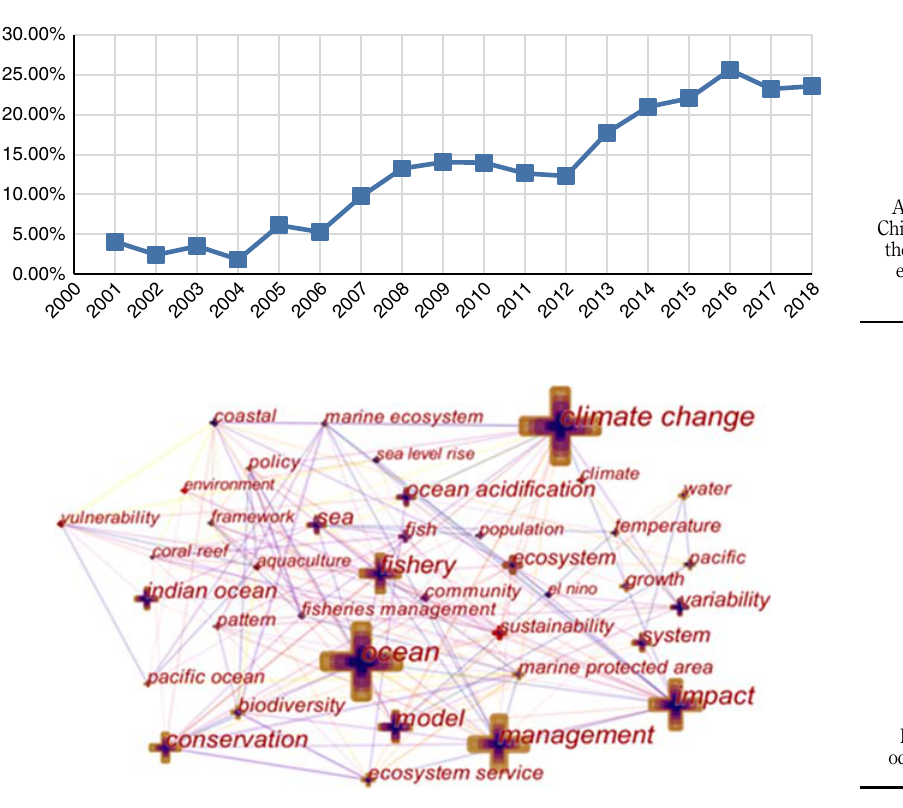
Figure 7. Keywords map